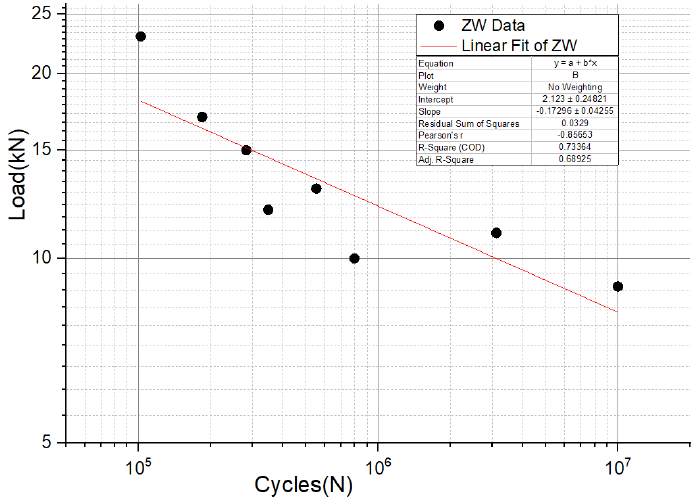
Figure 14. Fatigue life data and load – life curve of structure component.